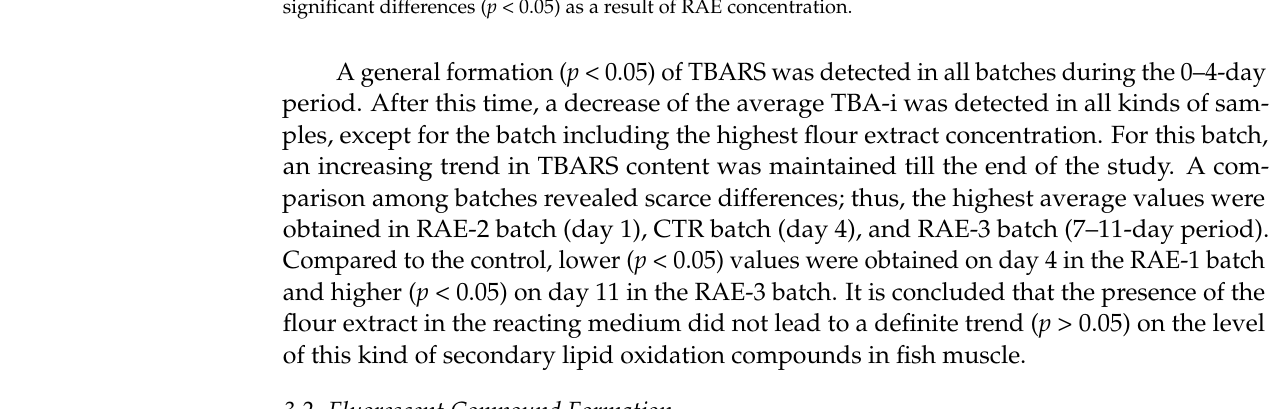
* Abbreviations of RAE concentrations as expressed in Table 1. Mean values of three independent determinations ( n = 3); standard deviations are shown in brackets. Mean values followed by lowercase letters (a–d) denote significant differences ( p < 0.05) as a result of heating time; mean values followed by capital letters (A–C) denote significant differences ( p < 0.05) as a result of RAE